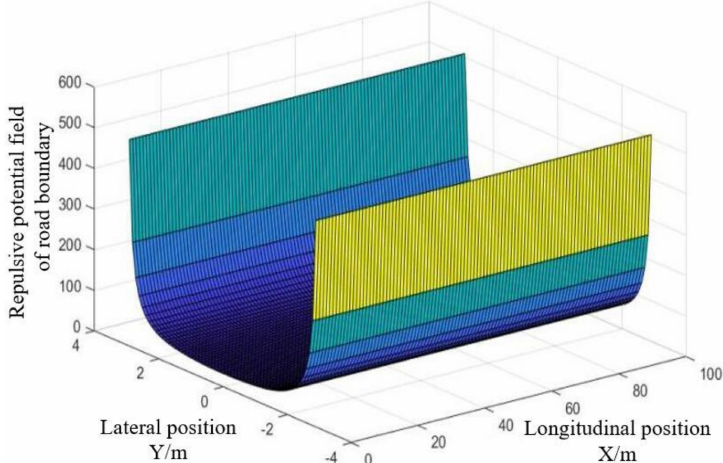
Figure 13. Repulsive potential field of road boundary.